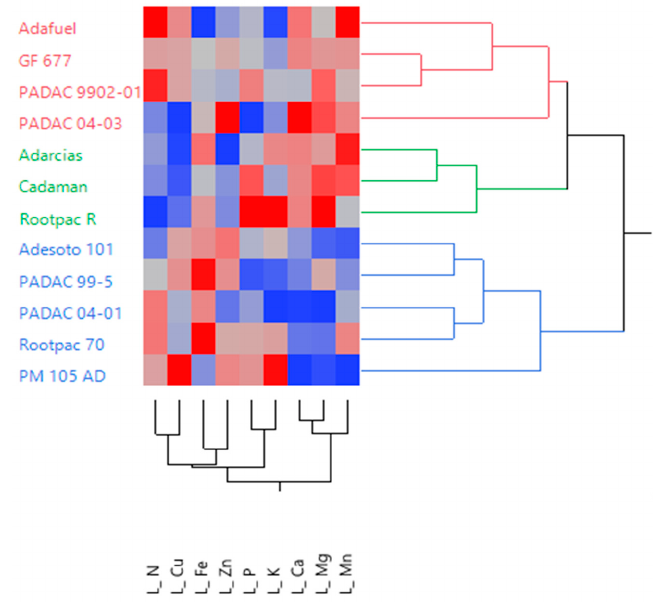
Figure 5. Rootstocks and leaf nutrients grouped by similarities in mineral nutrient concentration mean values. Higher trait values are red whereas lower means are blue and average values are gray. Rootstocks labeled in red belong to Cluster 1, labeled in green to Cluster 2, and labeled in blue to Cluster